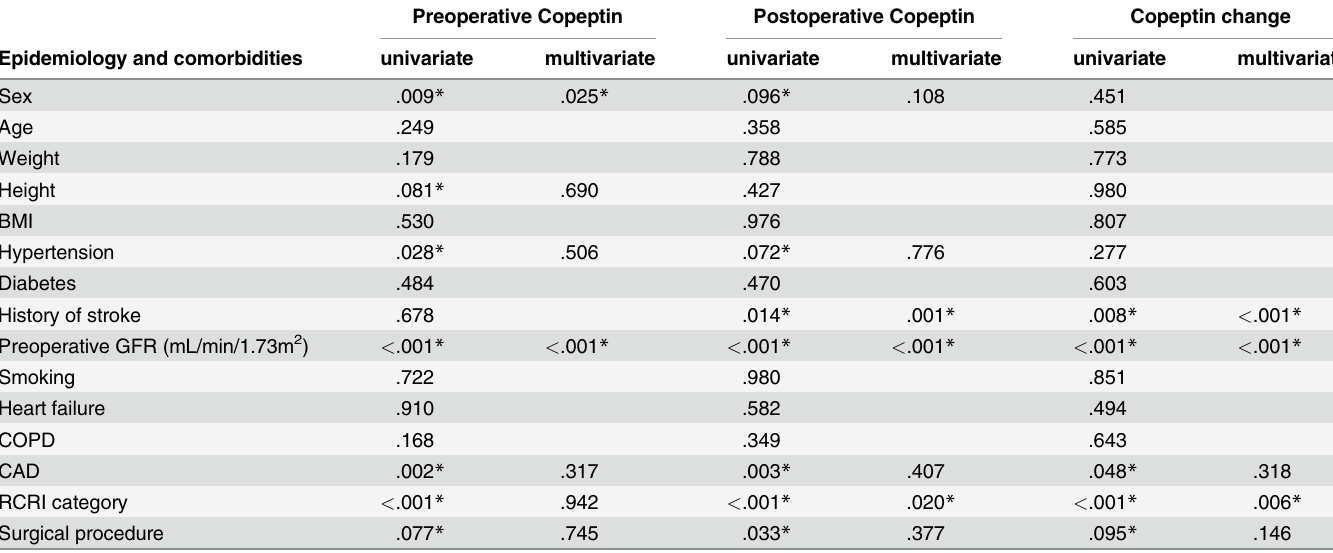
Table 3. Analysis of Copeptin